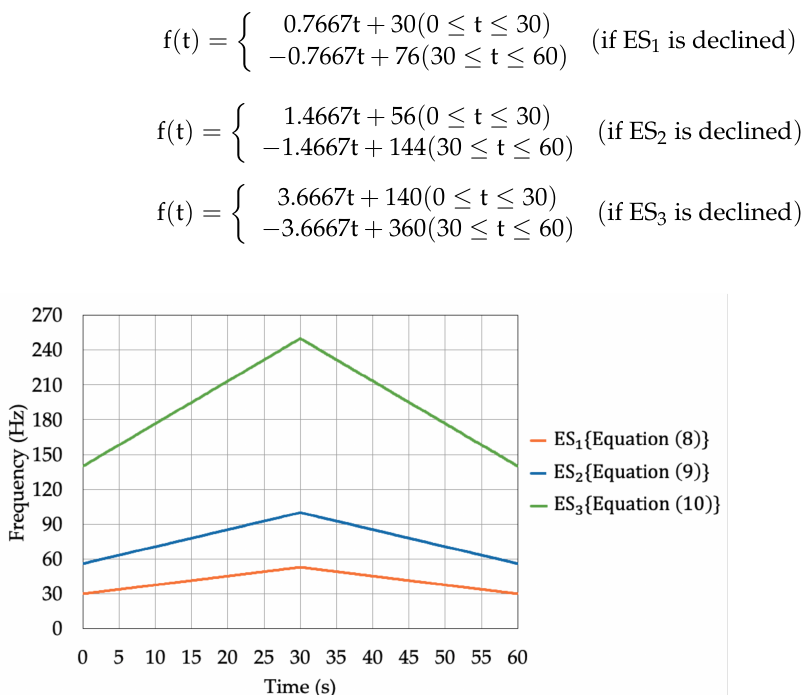
Figure 4. Frequency of local vibratory stimulation for the poor proprioceptor. ES = evaluation sections. The subscript numbers of ES are indicated as follows: 1 = muscle spindles (lower frequency), from 30 to 53 Hz; 2 = muscle spindles (higher frequency), from 56 to 100 Hz; 3 = Vater-Pacini corpuscle, from 140 to 250